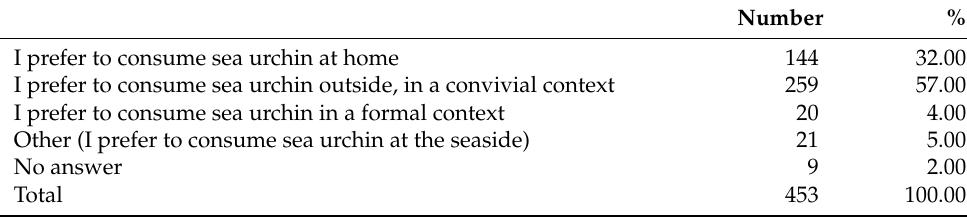
Table 8. Apulia consumers’ behavior related to sea urchin